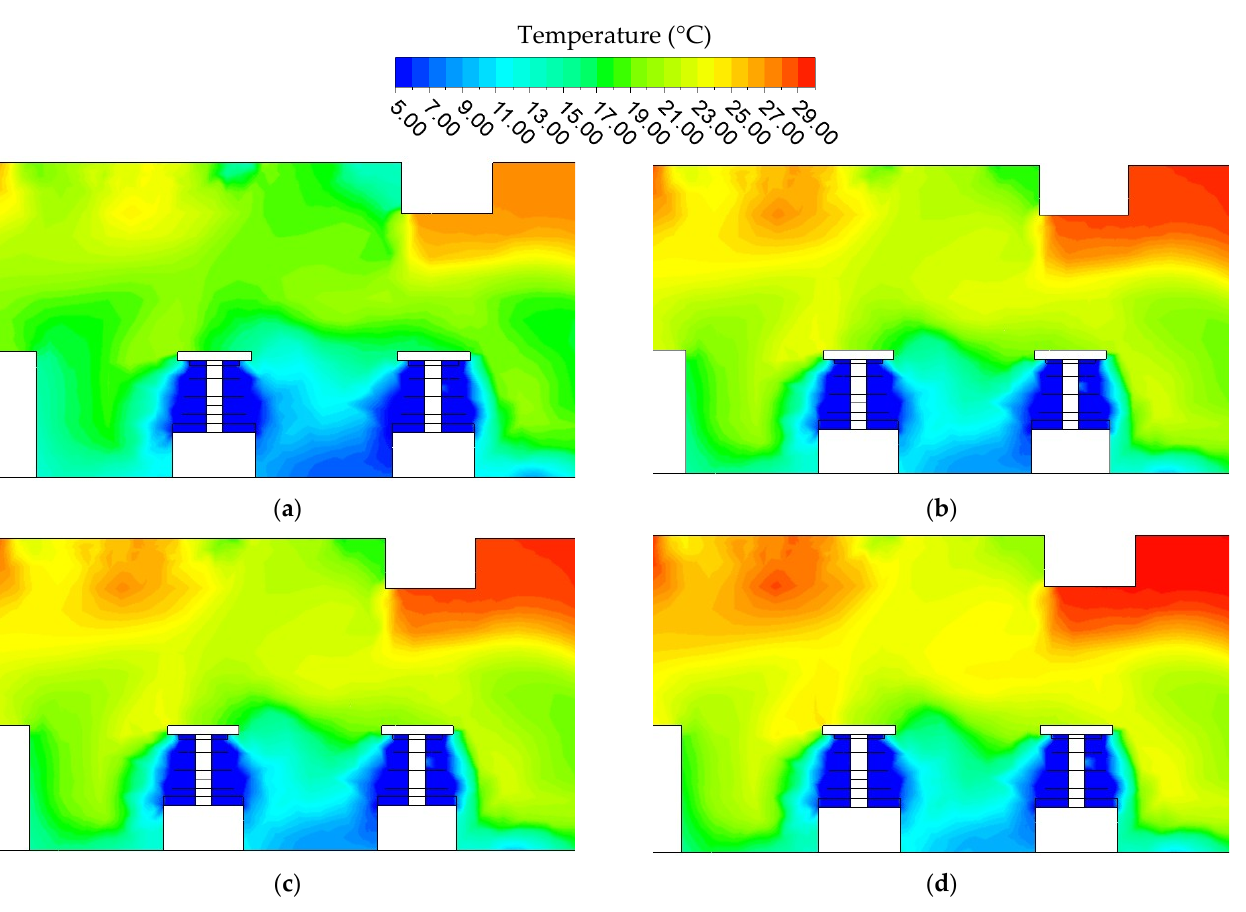
Figure 8. Temperature distributed profile at different thermostat set point (v = 2.5/s); ( a ) T = 22 °C; ( b ) T = 24 °C; ( c ) T = 26 °C; ( d ) T = 28 °C .